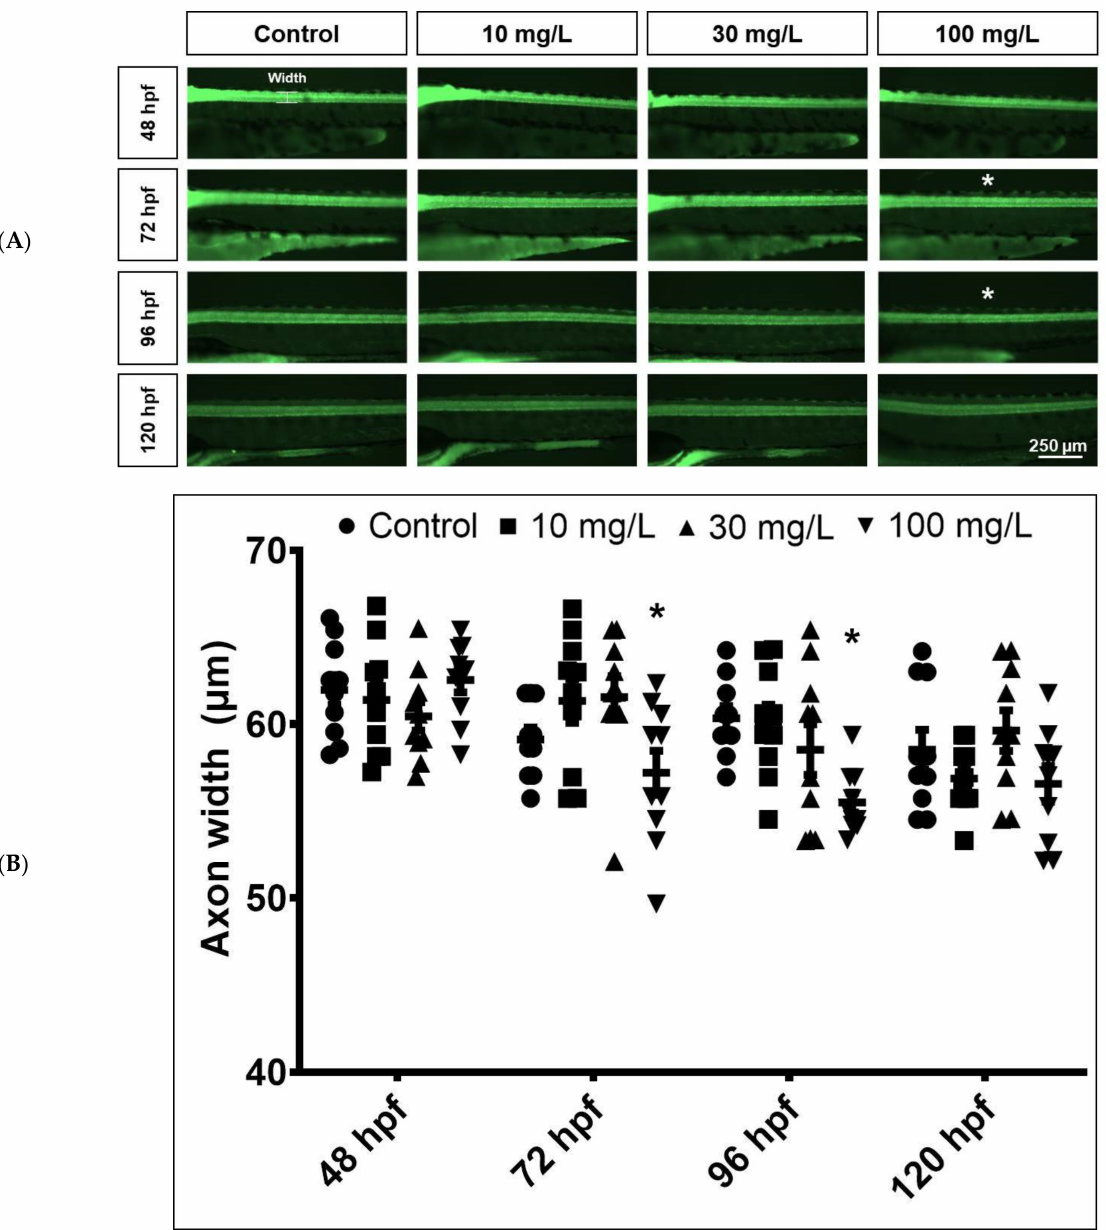
Figure 4. Comparison of spinal cord neuronal width between controls and acrylamide-treated zebrafish. ( A ). Spinal cord neuron width was similar between groups until 48 hpf. Between 72 and 96 hpf, fish treated with 100 mg/L acrylamide exhibited shorter spinal cord width (white asterisks). ( B ). Spinal cord neuronal width ( n = 10). * p < 0.01. Error bars represent the standard error of the